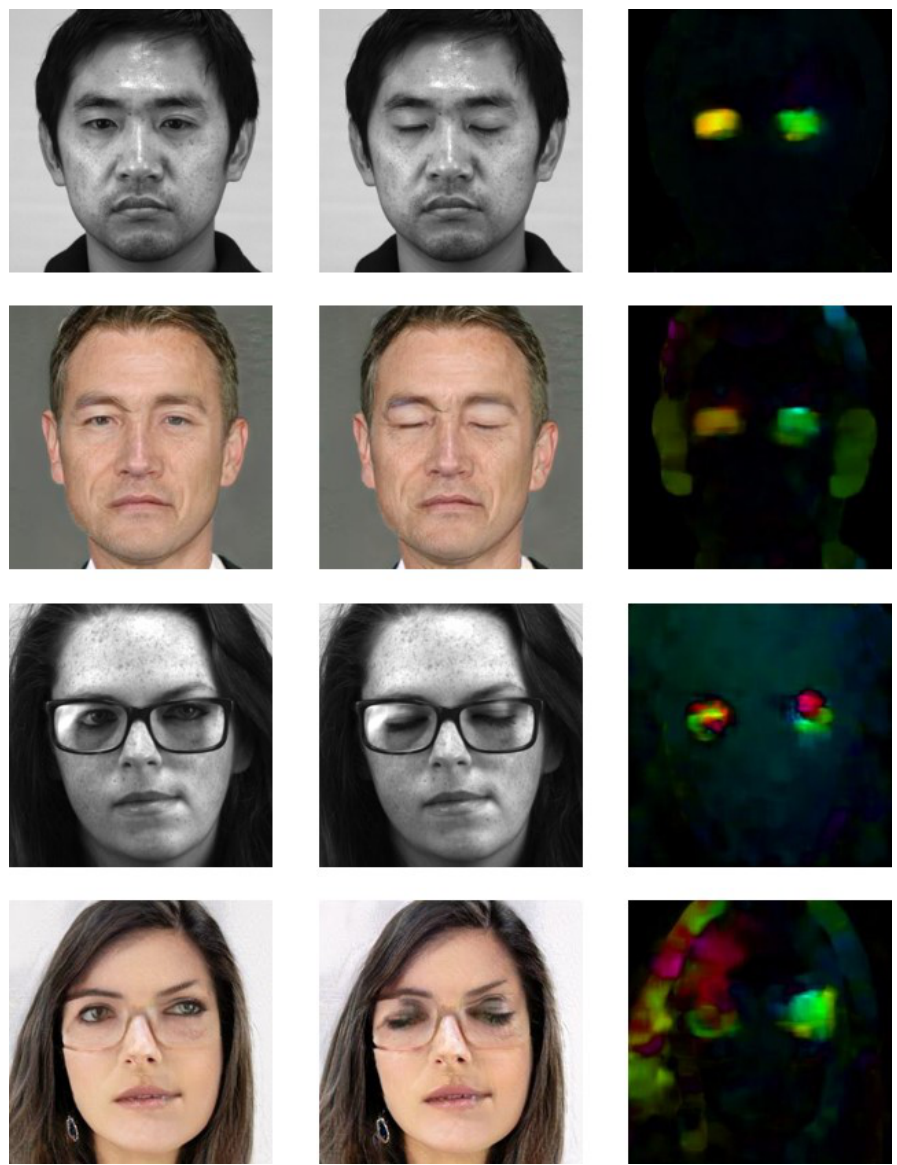
Figure 8. Eye blinks can cause changes in other facial regions. ( Top ) Mild case which results in small changes of hair and ears in the synthetic images. ( Bottom ) Extreme case on participant with glasses which results in huge